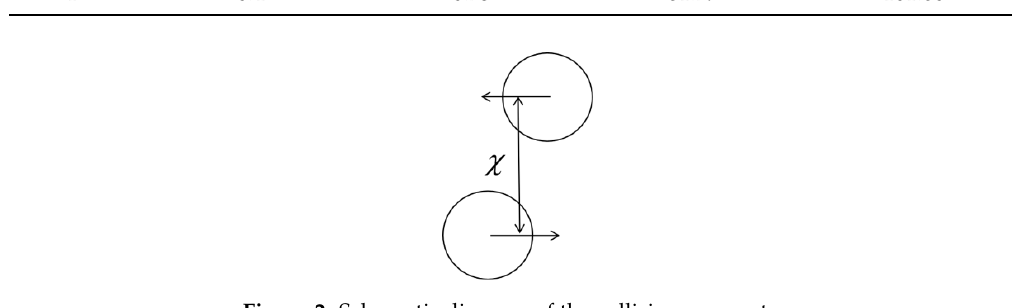
Figure 2. Schematic diagram of the collision parameter.